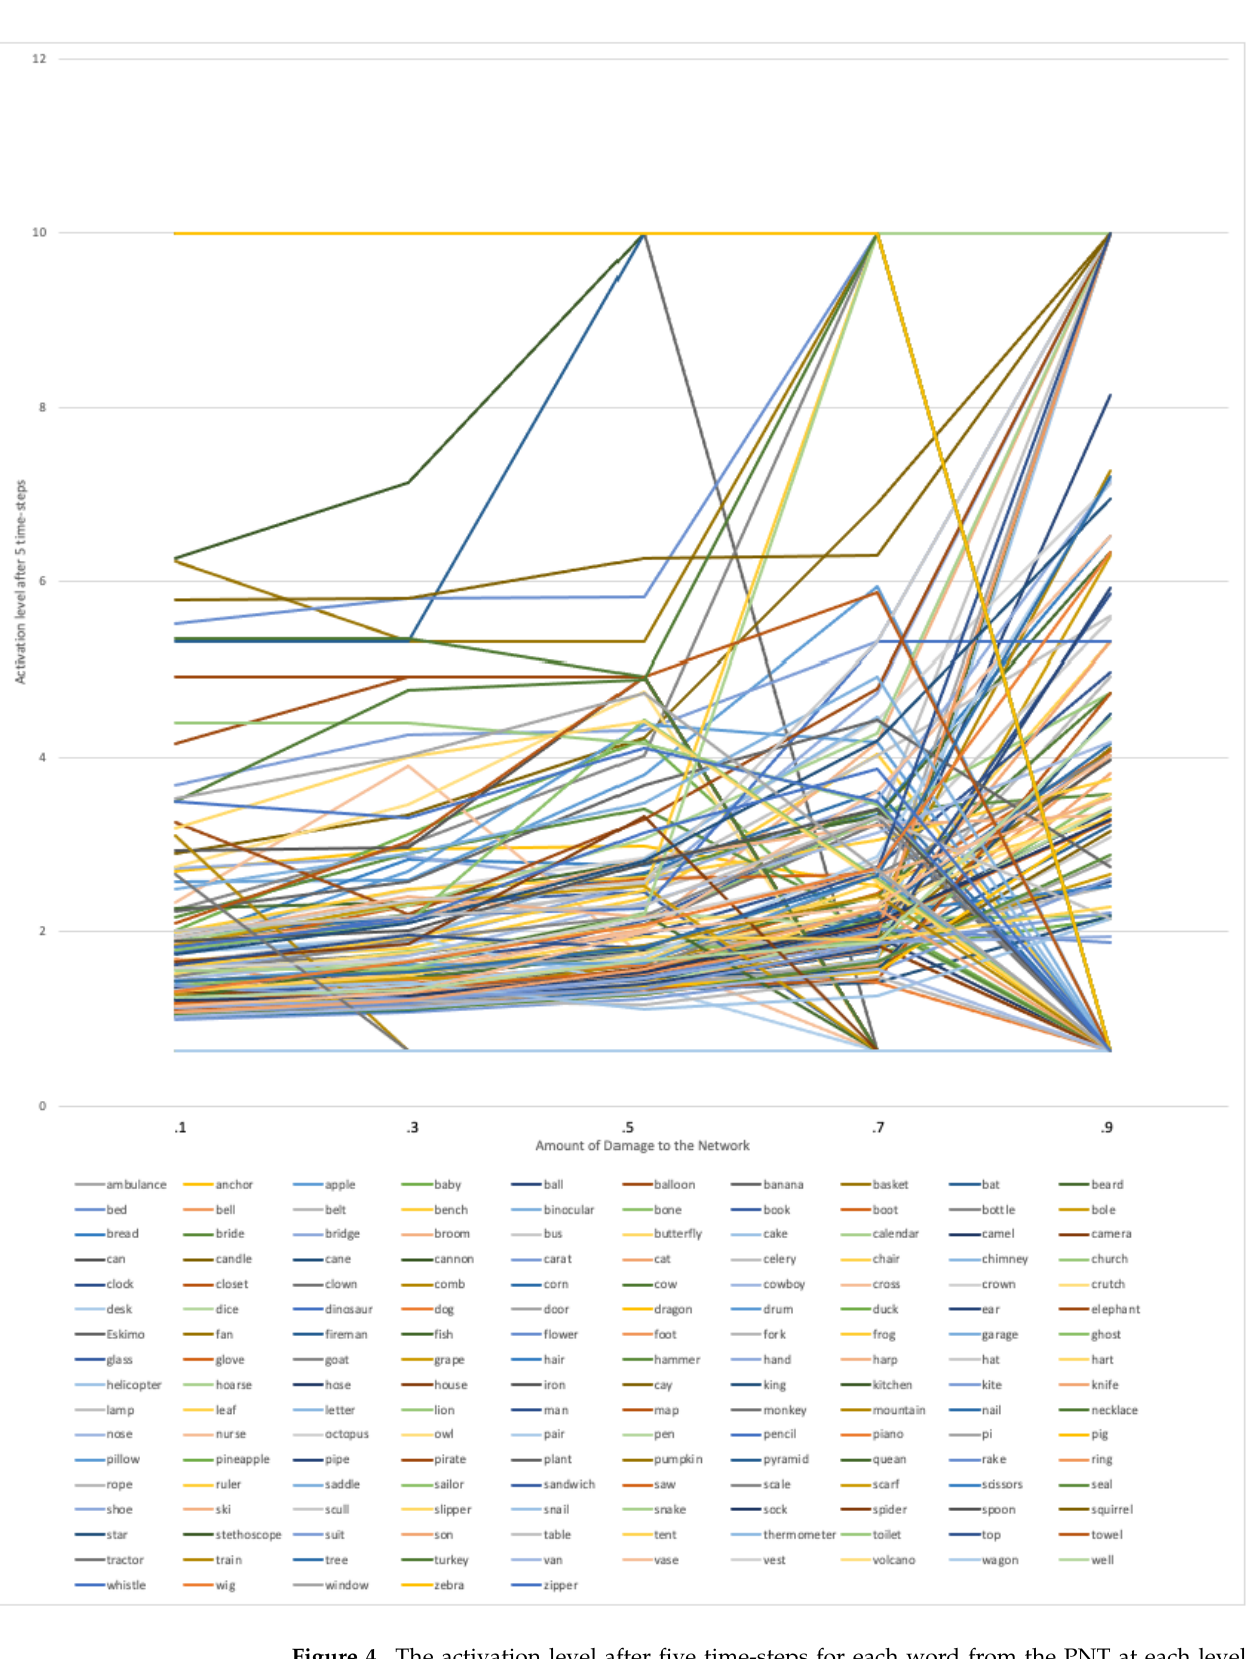
Figure 4. The activation level after five time-steps for each word from the PNT at each level of damage to the phonological network.